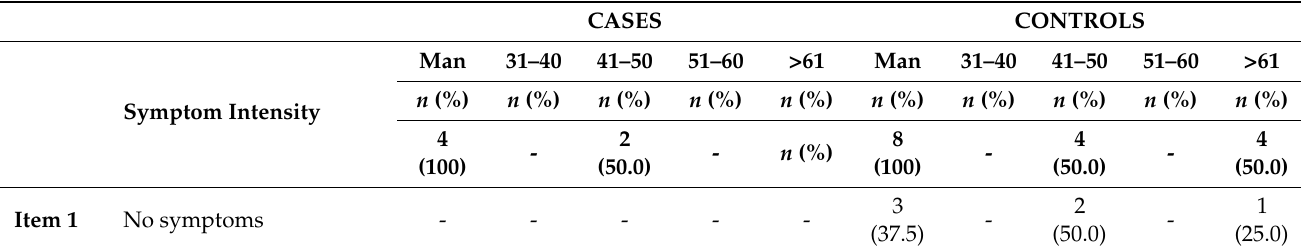
Table A2. Frequencies of the scores assigned to each item of Scale 3 of the QEESI questionnaire in